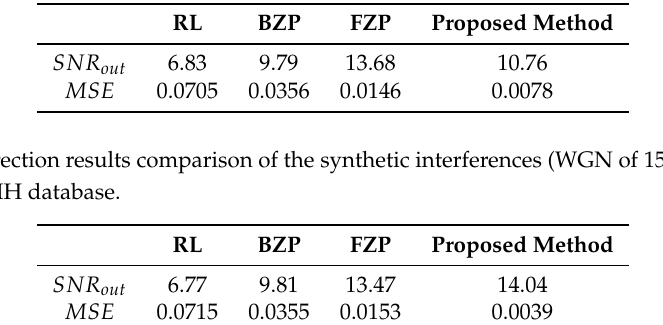
Table 5. The correction results comparison of the EMG interferences in the signal 115 of the MIT-BIH database.